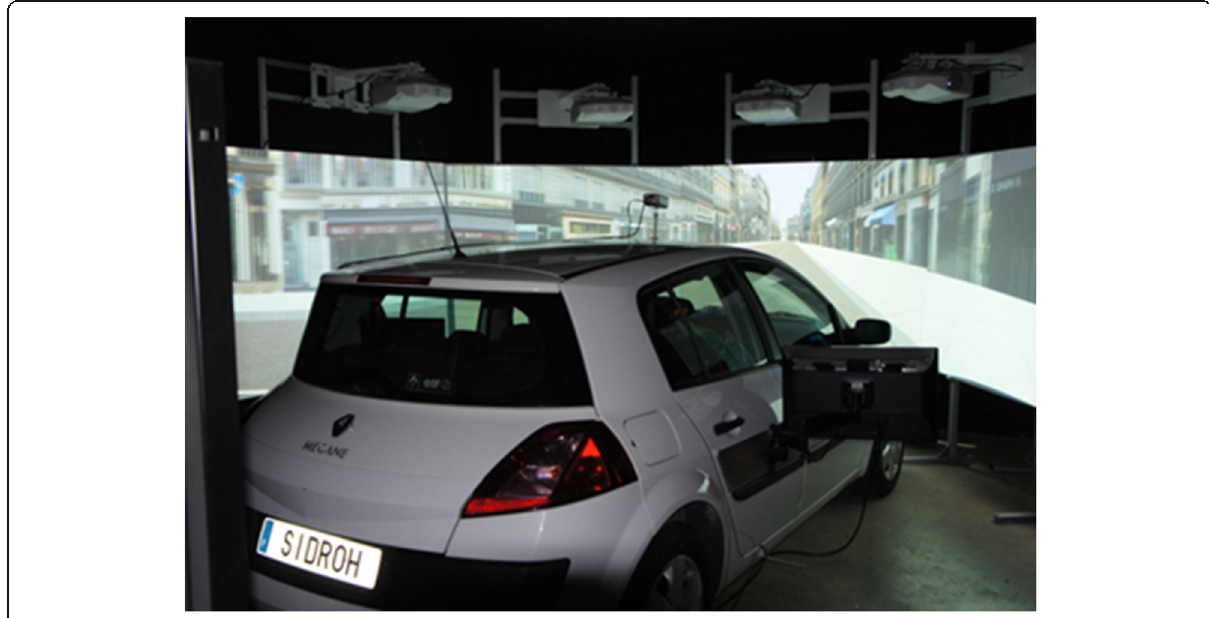
Fig. 1 The simulator used for the experiment